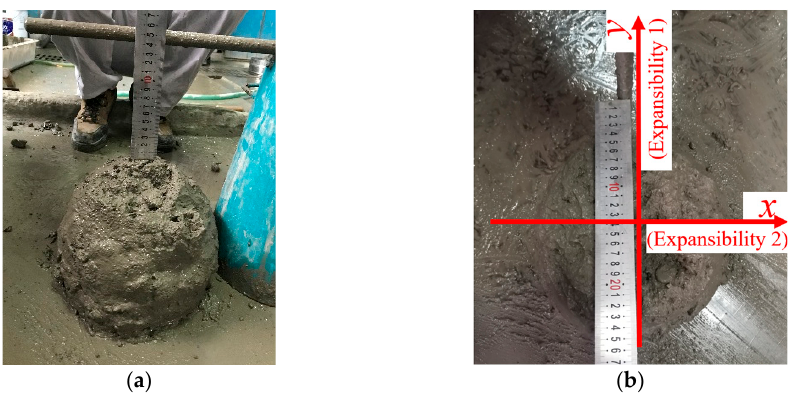
Figure 2. Workability test ( ρ = 0.6): ( a ) slump test; ( b ) expansibility test.